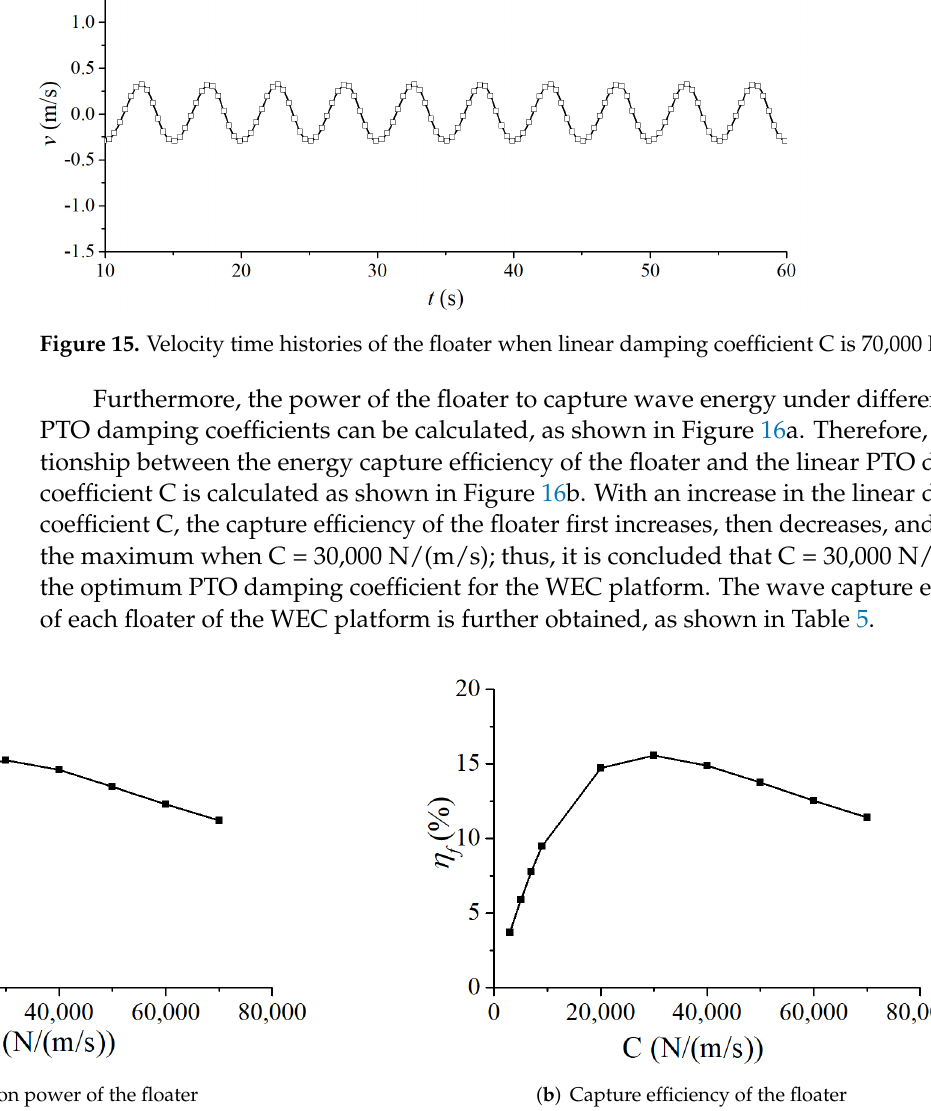
Figure 16. Generation power and capture efficiency of the floater to capture wave energy under different linear PTO damping coefficients. Table 5. Capture efficiency of each